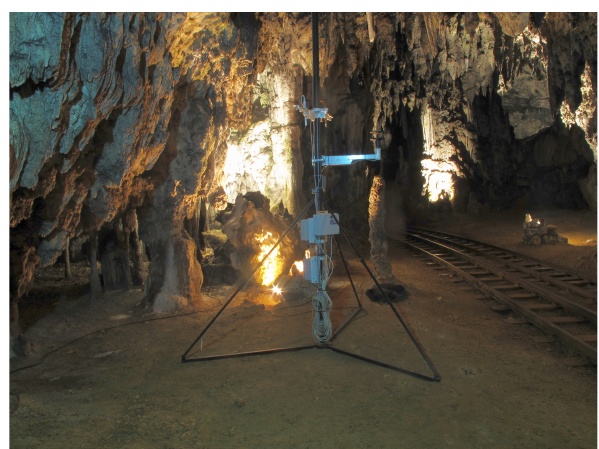
Fig. 5. Picture of static DTN node mounted by the railway in the cave where the train passes the cave meteorological station several times each